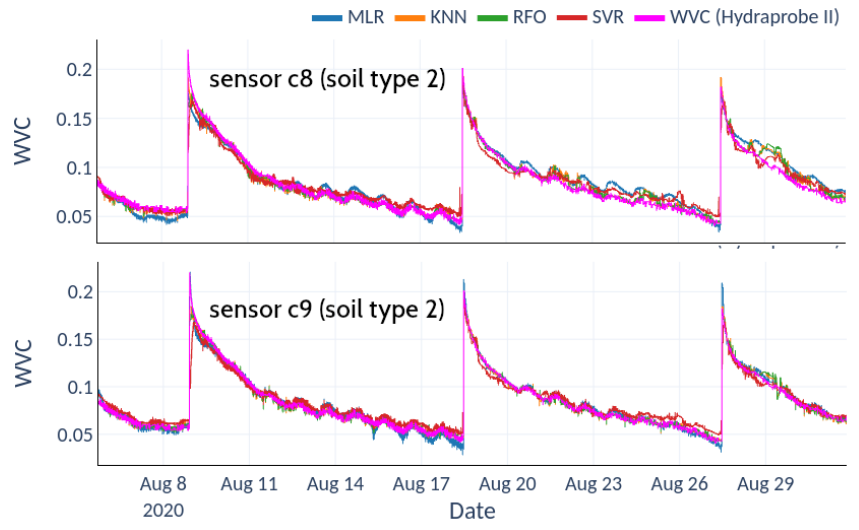
Figure 13. Predictions from machine-learning models superimposed on HydraProbe II records for soil type 2.